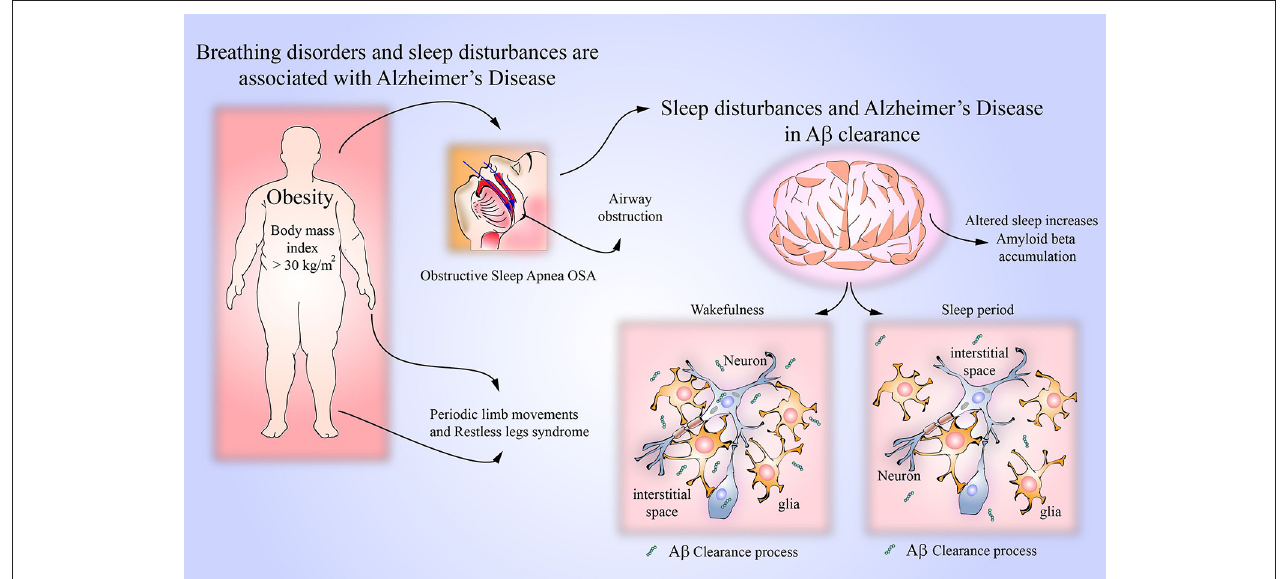
FIGURE 2 | Breathing disorders and amyloid beta clearance. It has been observed that sleep disorders in AD can be caused by obstructive sleep apnea (OSA). OSA is caused by an obstruction of respiratory airways, and its main risk overweight in obesity. Prospective studies have shown that patients with OSA may develop AD by several mechanisms such as neuroinflammation, oxidative stress and hypoxemia. Interestingly, clinical conditions like periodic limb movements and restless legs syndrome, which also lead to sleep disturbances, may be associated to AD. The removal of metabolites and neurotoxic compounds via glymphatic system is a function regulated by sleep and wakefulness activity. It is known that soluble amyloid beta can be cleared from the CNS parenchyma using the glymphatic system. Sleep may influence the clearance of amyloid beta due to the increased brain’s interstitial space possibly by the shrinkage of astroglial